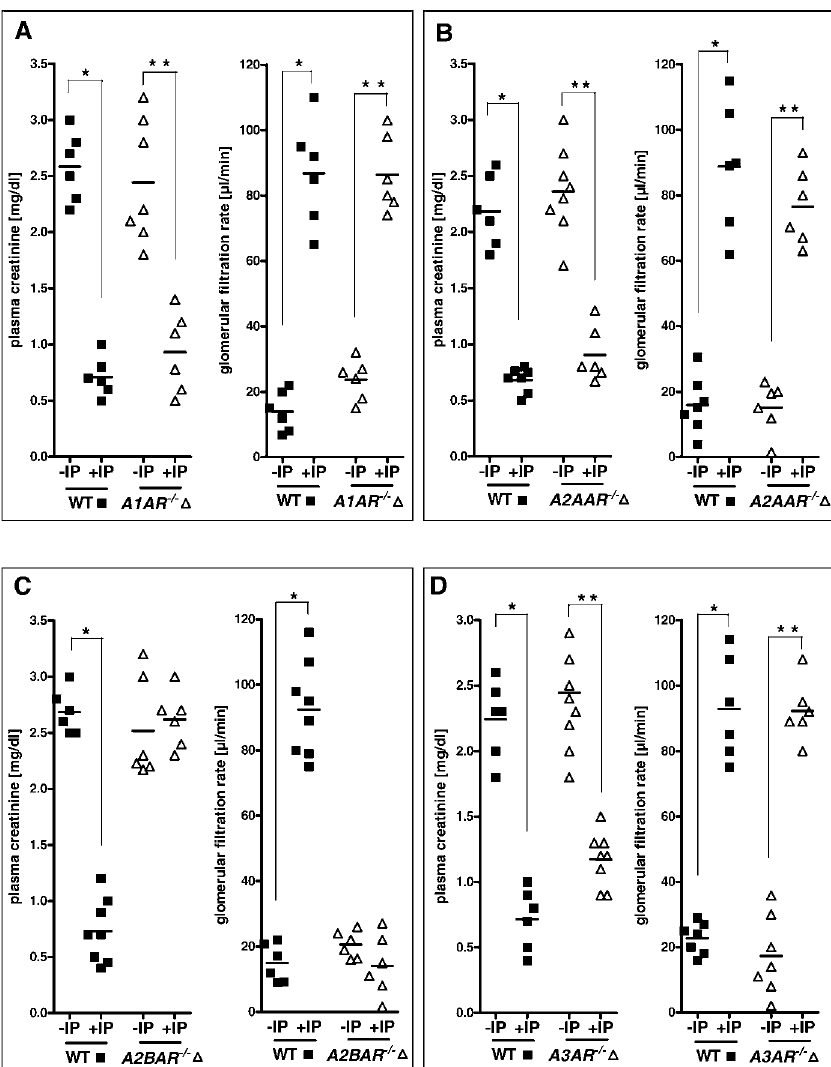
Figure 2. Renal Ischemia and Preconditioning in Gene-Targeted Mice for Individual ARs (A–D) Previously characterized A1AR (cid:2) / (cid:2) , A2AAR (cid:2) / (cid:2) , A2BAR (cid:2) / (cid:2) , and A3AR (cid:2) / (cid:2) mice or their respective age-, weight-, and gender-matched littermate controls (WT) were subjected to right nephrectomy followed by 45 min of left renal artery ischemia with or without prior in situ IP (consisting of four cycles of